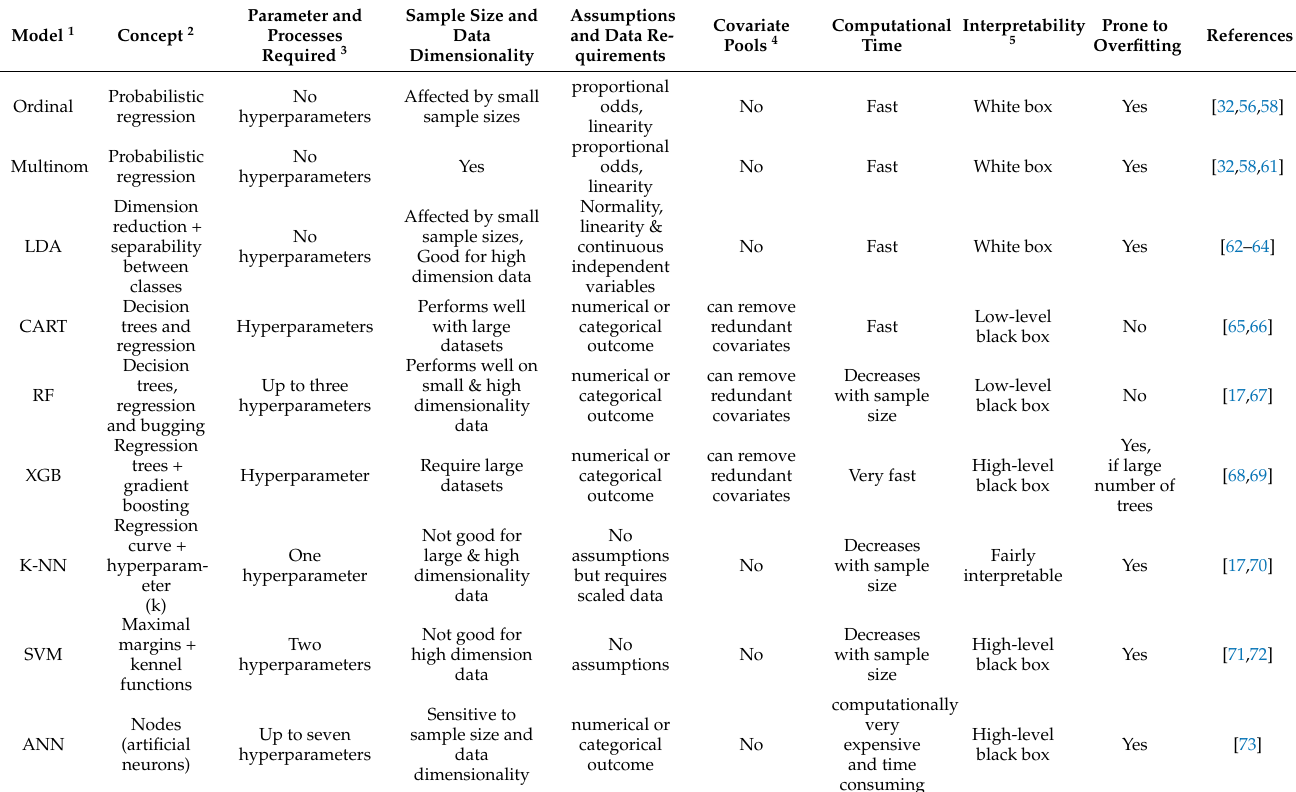
Table A1. Key model performance characteristics of common machine learning algorithms (selecting the most appropri- ate